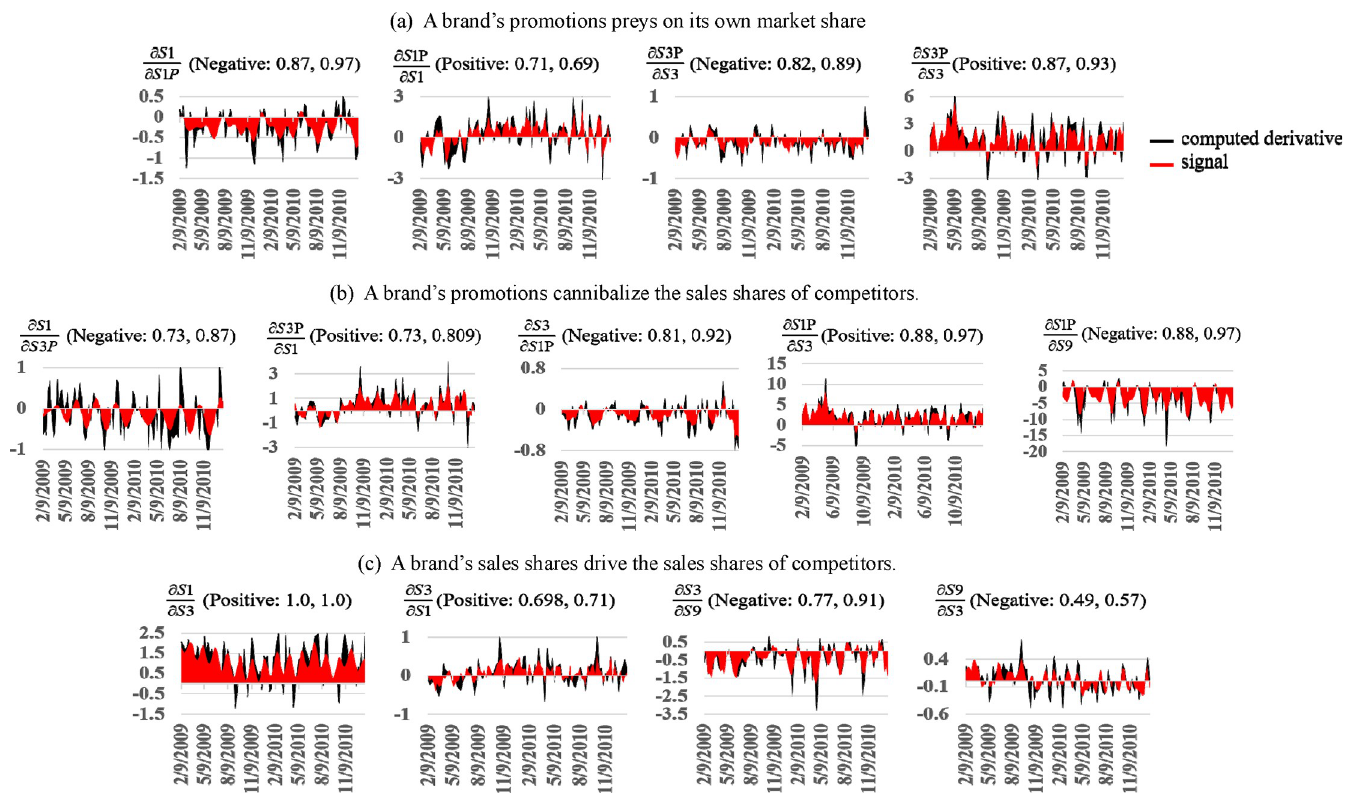
Fig 13. Quantified interactions. We embedded an empirical attractor with phase space coordinates provided by S1, S1P, S3, S3P, and S9, and applied S-mapping to compute partial derivatives quantifying interactions among these variables over time (black curves). The areas between the curves and the zero-axis are shaded black to highlight weeks when interactions are positive or negative. We next isolated the systematic components (signals) of the computed derivatives with singular spectrum analysis (shaded red). Since partial-derivative signals are mostly either positive or negative for the majority of weeks in the POR, we characterize them by: (1) the percentage of weeks that each partial-derivative signal is mostly positive/negative; and (2) the relative magnitude of positive/negative areas to total area between the curve and the zero-axis. These measures are reported in the headings to each plot. For example, ’ @ S1/ @ S1P (Negative: 0.87, 0.97)’ indicates that the partial derivative is negative 87% of the weeks, and that the negative area comprises 97% of the total area. The partial derivative signals indicate that: (a) A brand’s promotions preyed on its own sales shares (an outcome documented in the literature); (b) A brand’s promotions generated the offsetting benefit of cannibalizing sales shares of competing brands; and (c) The sales shares of ABInbev brands (S1 and S3) were mutually-beneficial, but the sales share of S3 was preyed on by the outside brand owned by a different brewery